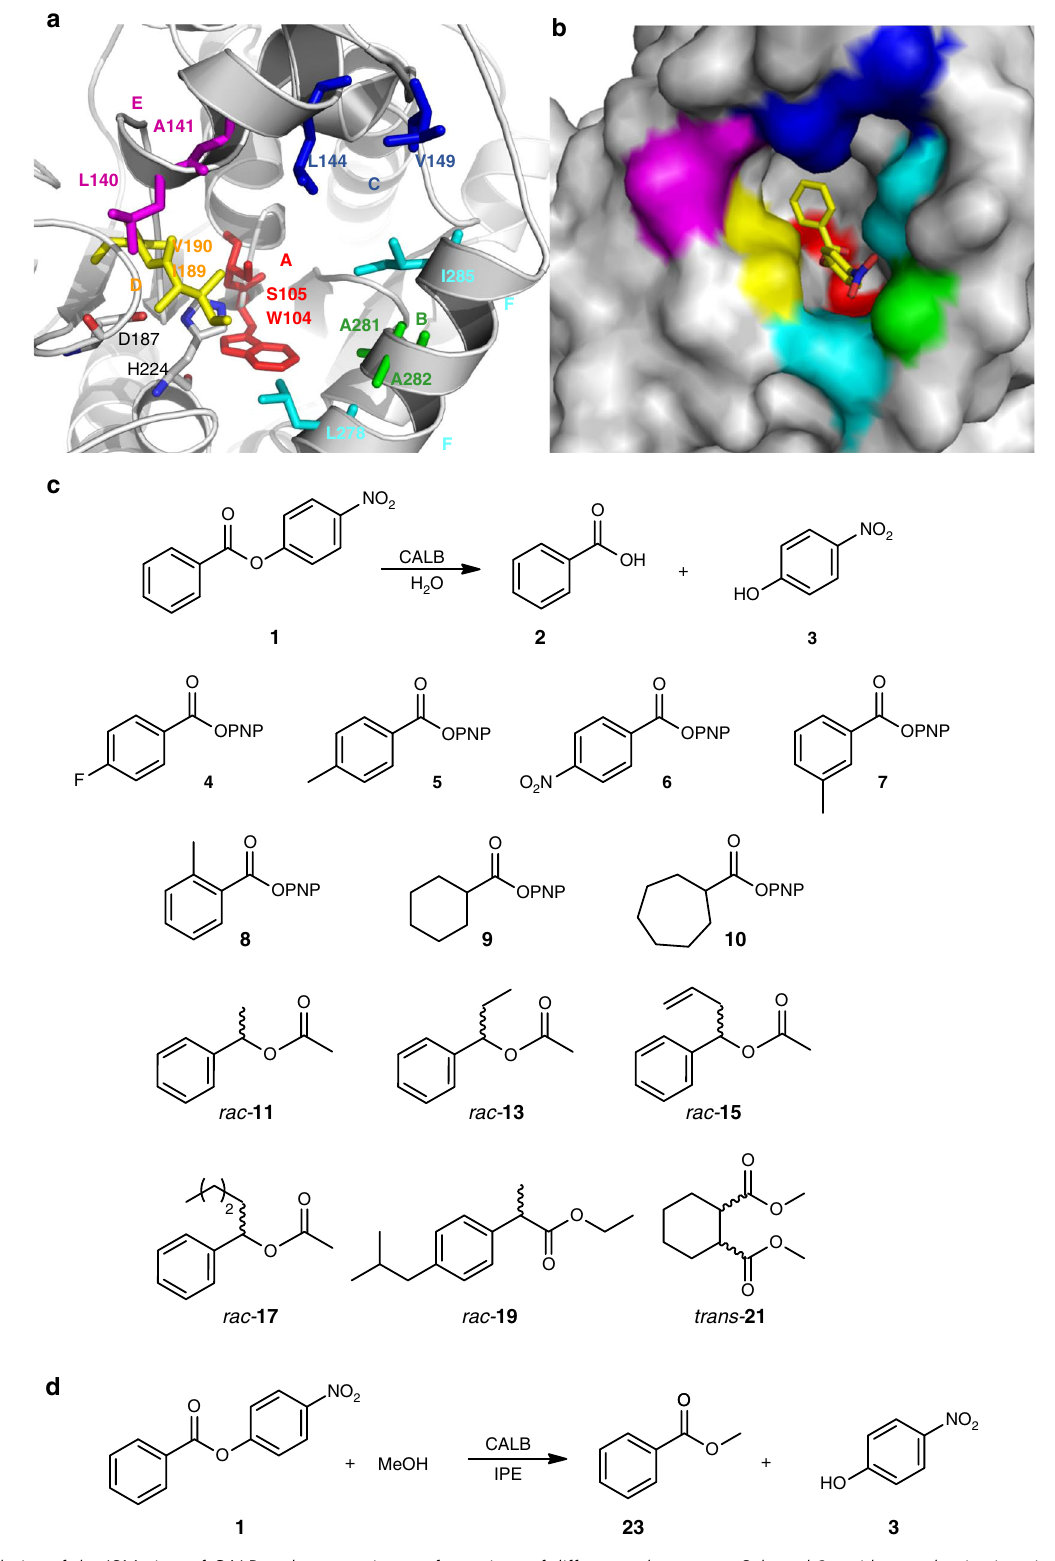
Fig. 2 The choice of the ISM sites of CALB and enzymatic transformations of different substrates. a Selected 2-residue randomization sites A-F for ISM based on the X-ray structure of CALB: 21 Site A (W104/S105, red), B (A281/A282, green), C (L144/V149, blue), D (I189/V190, yellow), E (L140/A141, purple), and F (L278/I285, cyan). The catalytic triad Asp187-His224-Ser105 are shown in gray and red stick illustrations. b Binding pocket surface of WT CALB with the docked substrate 1 . Mutagenesis sites A, B, C, D, E and F are shown as surface illustration with the same color coding as in a . c – d , Structure and reactions of tested